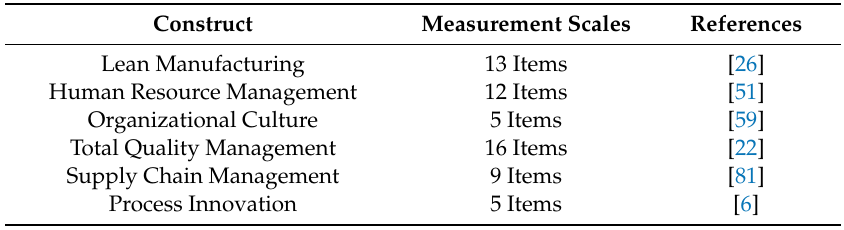
Table 2. Measurement scales and corresponding references for all the constructs.